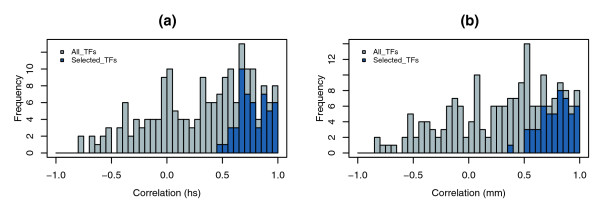
Distribution and frequency of LODog and LODco correlations from 19 distance constraints for individual TFBSs. (a) Distribution and frequency of correlation for all 243 TFBSs (grey) and for the 51 selected TFBSs (blue) from human (hs). (b) Distribution and frequency of correlation for all 243 TFBSs (grey) and for the 51 selected TFBSs (blue) from mouse (mm).